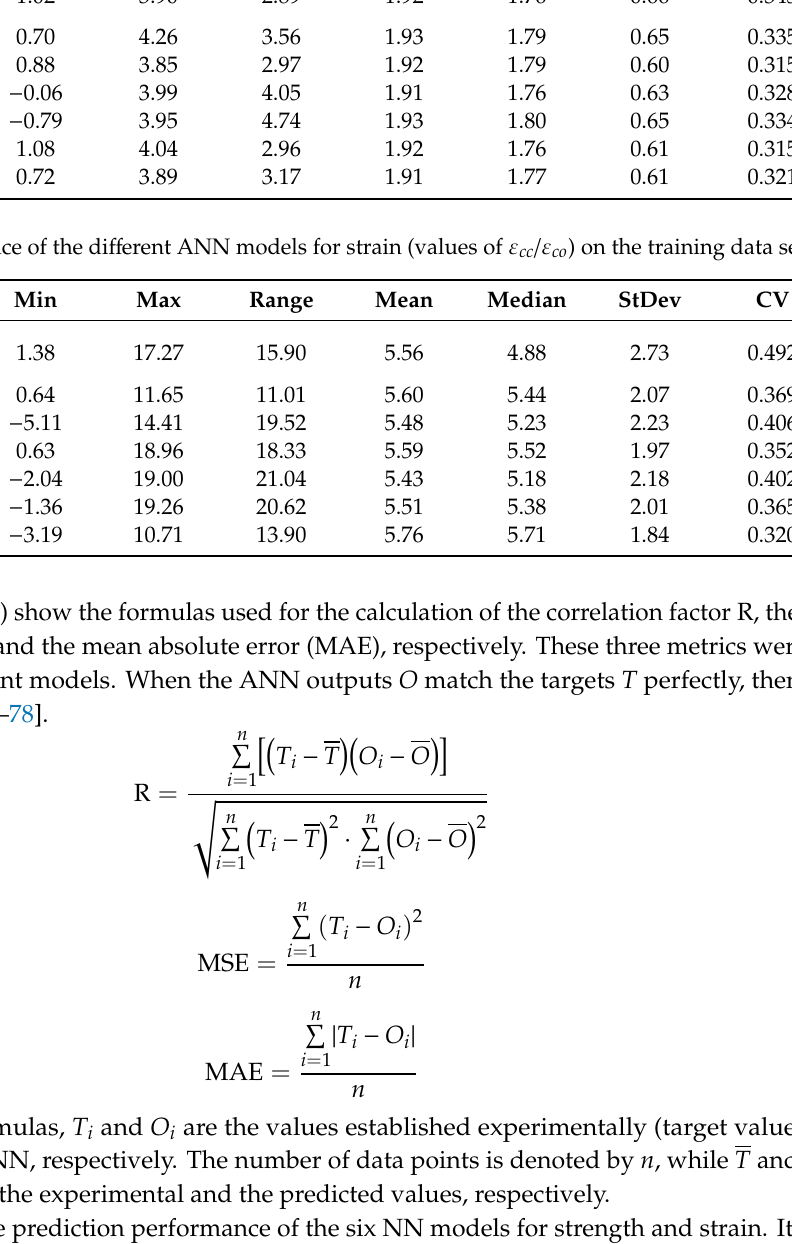
Table 6. Performance of the di ff erent ANN models for strength (values of f cc / f (cid:48) co ) on the training data set. Min Max Range Mean Median StDev CV Experimental (target values)